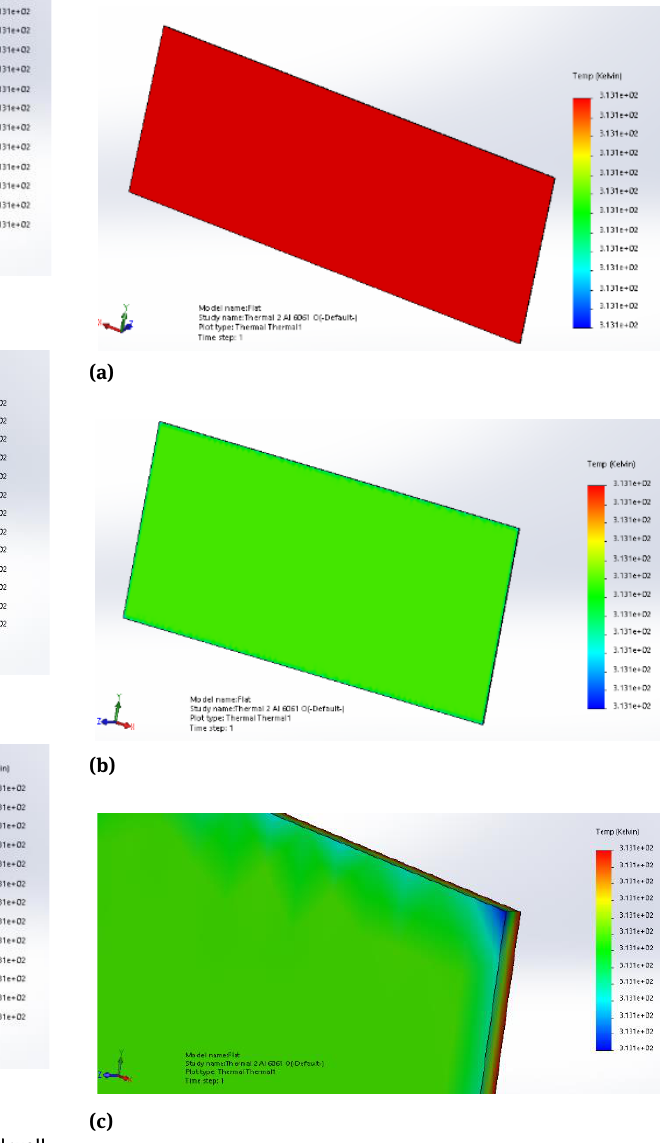
Figure 22: Result of the thermal simulation for the corrugated wall: (a) outer surface, (b) inner surface, and (c) edge Figure 23: Result of the thermal simulation on the flat wall: (a) outer surface, (b) inner surface, (c)